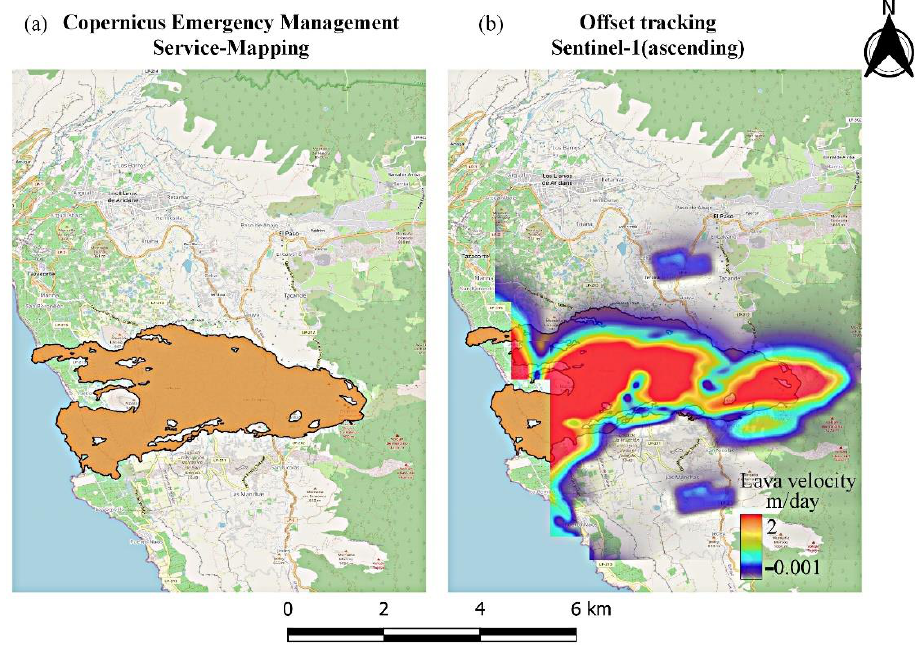
Figure 14. ( a ) Extent of lava flow, as released by Copernicus Emergency Management Service-Mapping [63]. ( b ) Lava flow, obtained by processing the Sentinel-1 ascending data through offset tracking.